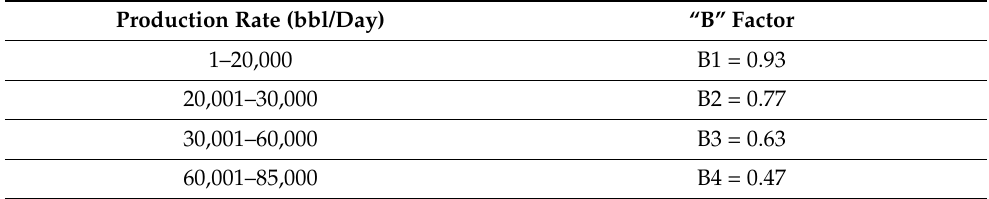
Table 3. “B” factor decreases when the production rate